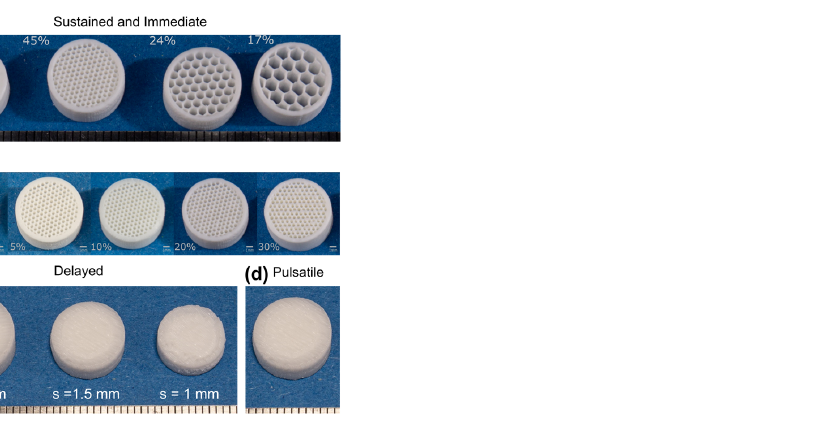
Figure 5. Images of sustained and immediate release tablet ( a ) with constant drug content (10% drug loading) and varying infill, ( b ) with varying drug content (5–30% drug loading) and constant infill (45%). ( c ) Delayed release tablet with 1, 1.5 and 2 mm shell thickness (10% drug loaded core), and ( d ) pulsatile release tablets. Ruler unit: 1 mm.